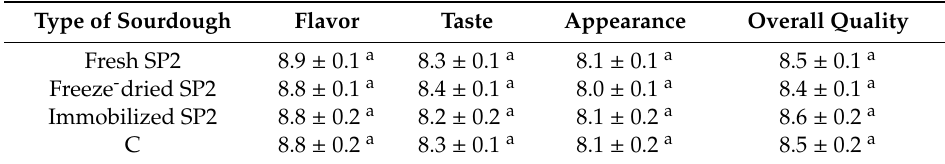
Table 3. Scores of the customer-oriented sensory evaluation of the breads made with sourdoughs prepared with P. pentosaceus SP2 cells in free-form (Fresh SP2), freeze-dried form (Freeze-dried SP2), and immobilized freeze-dried form (Immobilized SP2), as well as with the commercial sourdough